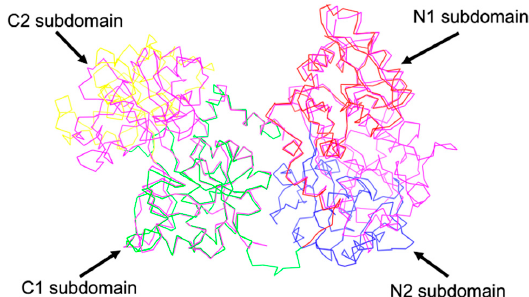
difference between the N and C lobes [17]. The N-lobe hinge is formed of longer strands consisting the same sheet in the N-lobe and contains the hinge in an unstructured region. This suggests that the Figure 4. Sequence alignment of human apo-sTf and diferic pig sTf (magenta colored protein). PDB code for human apo-sTf: 2HAV, PDB code for diferric pig sTf: 1H76.